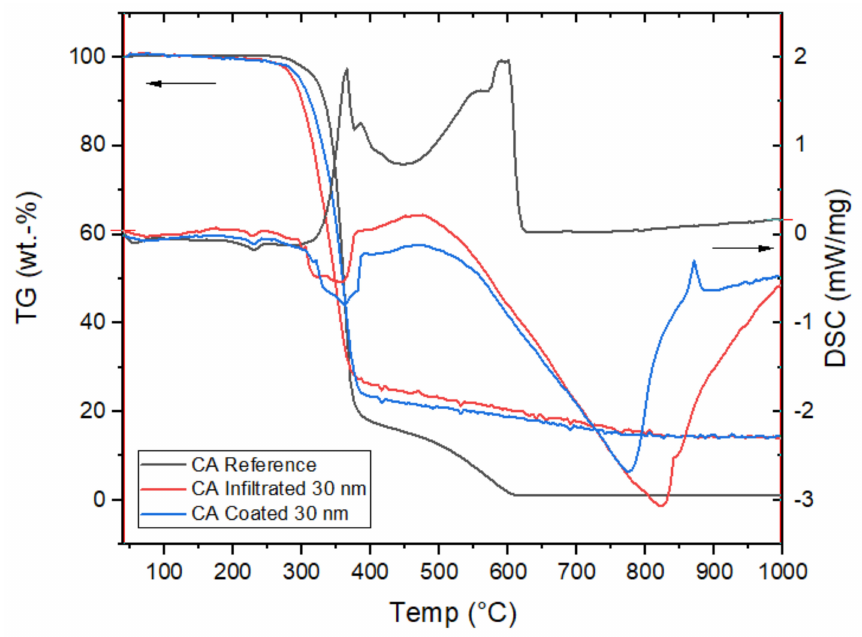
Figure 14. TGA and DSC curves of CA (black), and CA treated with Al 2 O 3 by 30 nm ALD coating (blue), and after 300 infiltration cycles